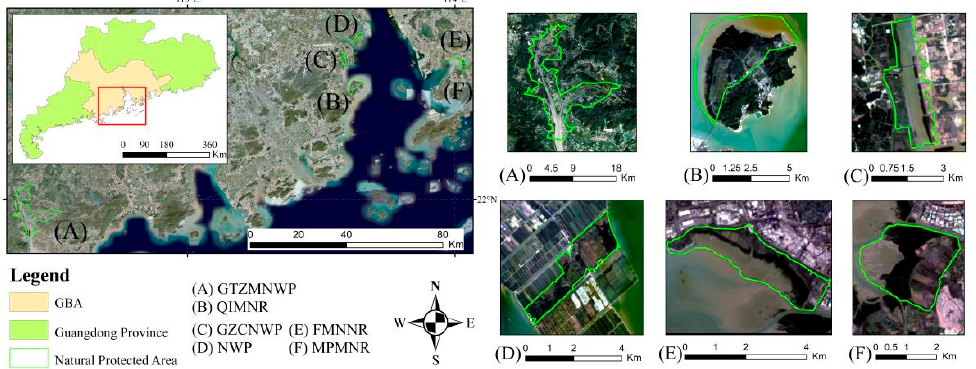
Figure 1. The geographical locations of GBA and nature reserves. ( A ) GTZMNWP, ( B )